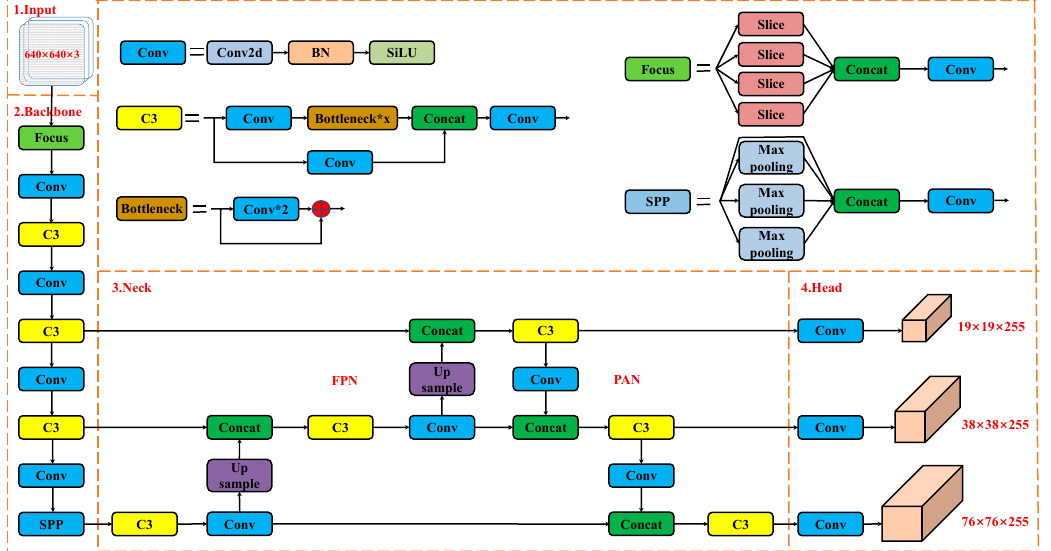
Figure 1. The input terminal, the Backbone network, the Neck network, and the head output terminal are the four parts of the classic YOLOv5 network structure.